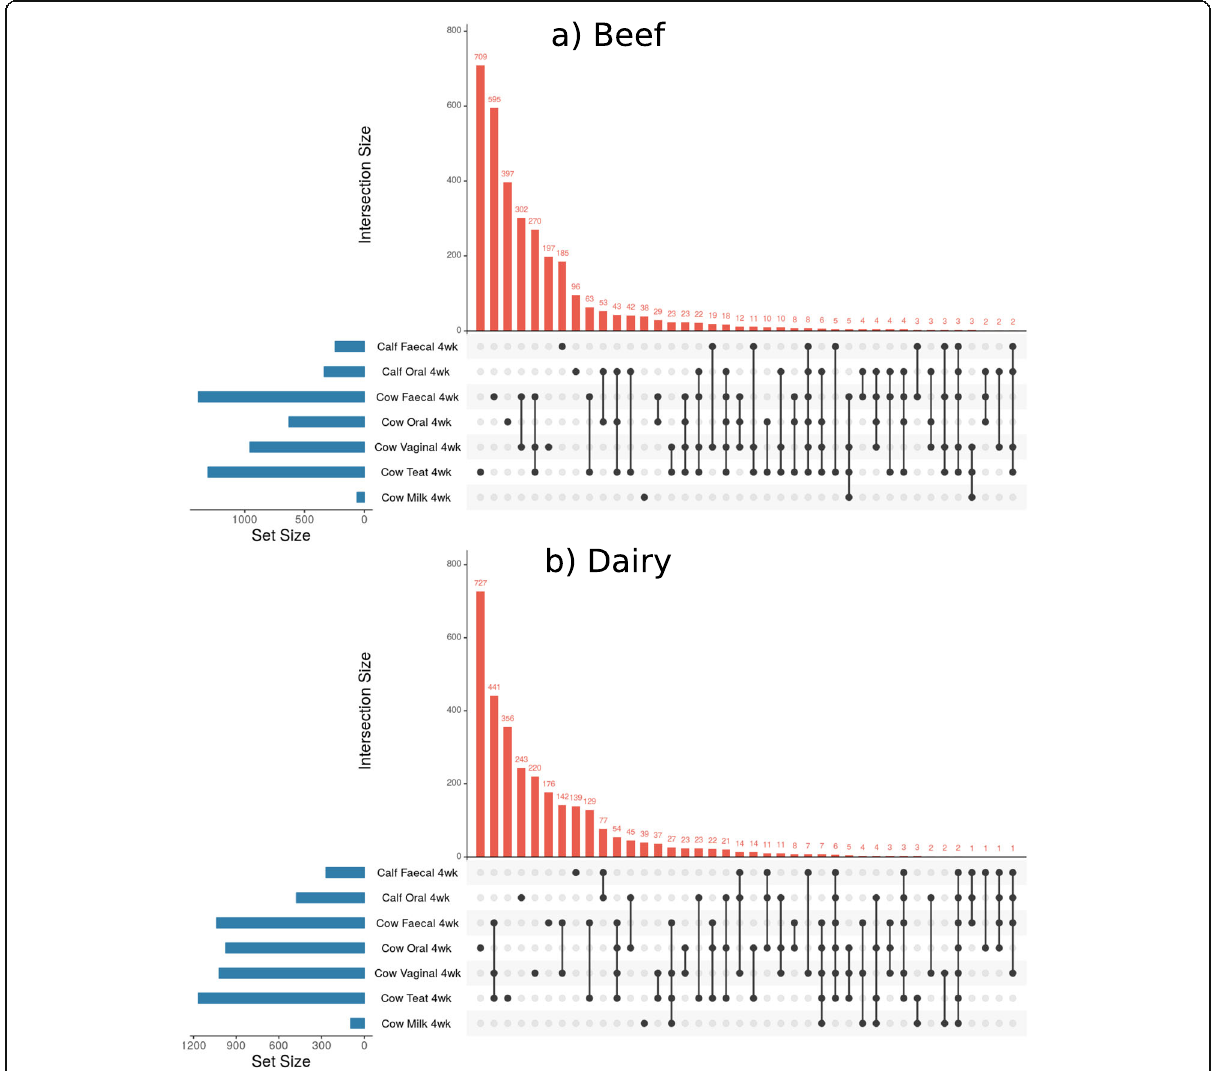
Fig. 6 UpSet plots of common assigned sequence variants (ASVs) between samples at 4 weeks postpartum. Beef ( a ) and dairy ( b ) animals are displayed separately. All samples collected at “ 4wk ” (four-weeks postpartum) are displayed. Only ASVs with an overall abundance across all samples of greater than 0.01% are included, the 30 intersections which involve the greatest number of ASVs are displayed. The number of individual animals in each group (set): N = 5. Taxonomy of each intersection is detailed in Supplementary Table 4 and